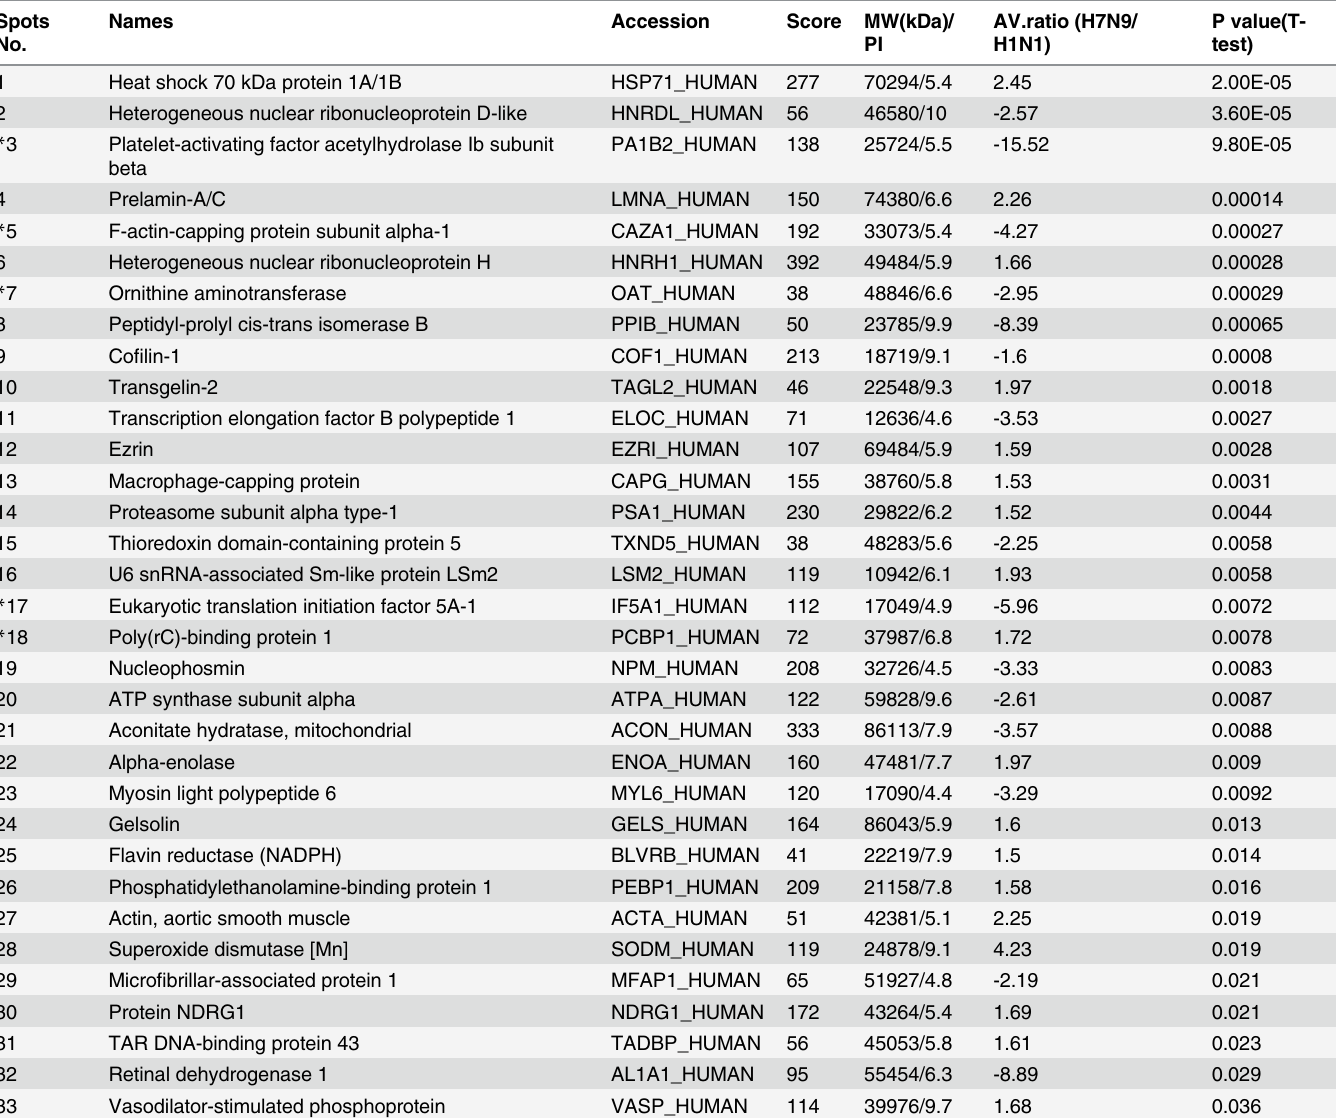
Table 3. Identification of differentially expressed proteins in A549 cells infected with H7N9 and H1N1pdm09 influenza virus at 72hpi. Spots